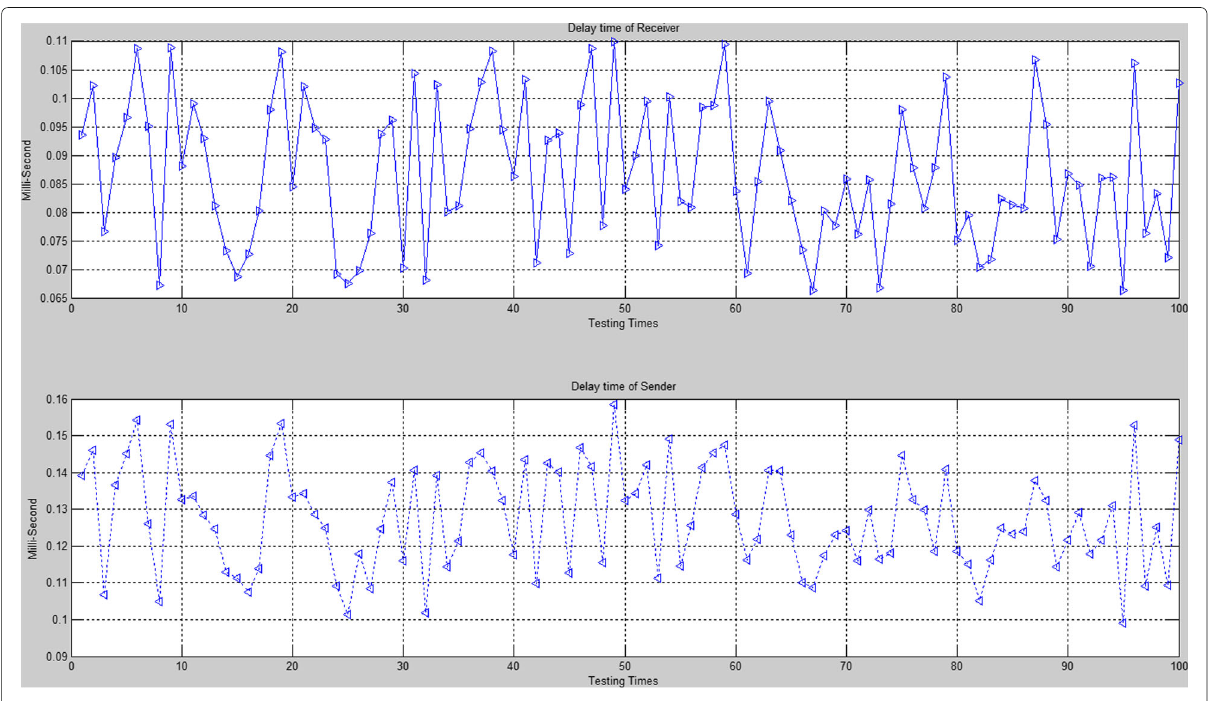
Fig. 12 Network traffic delay test between secure mVoIP apps in Gwangju metro-city